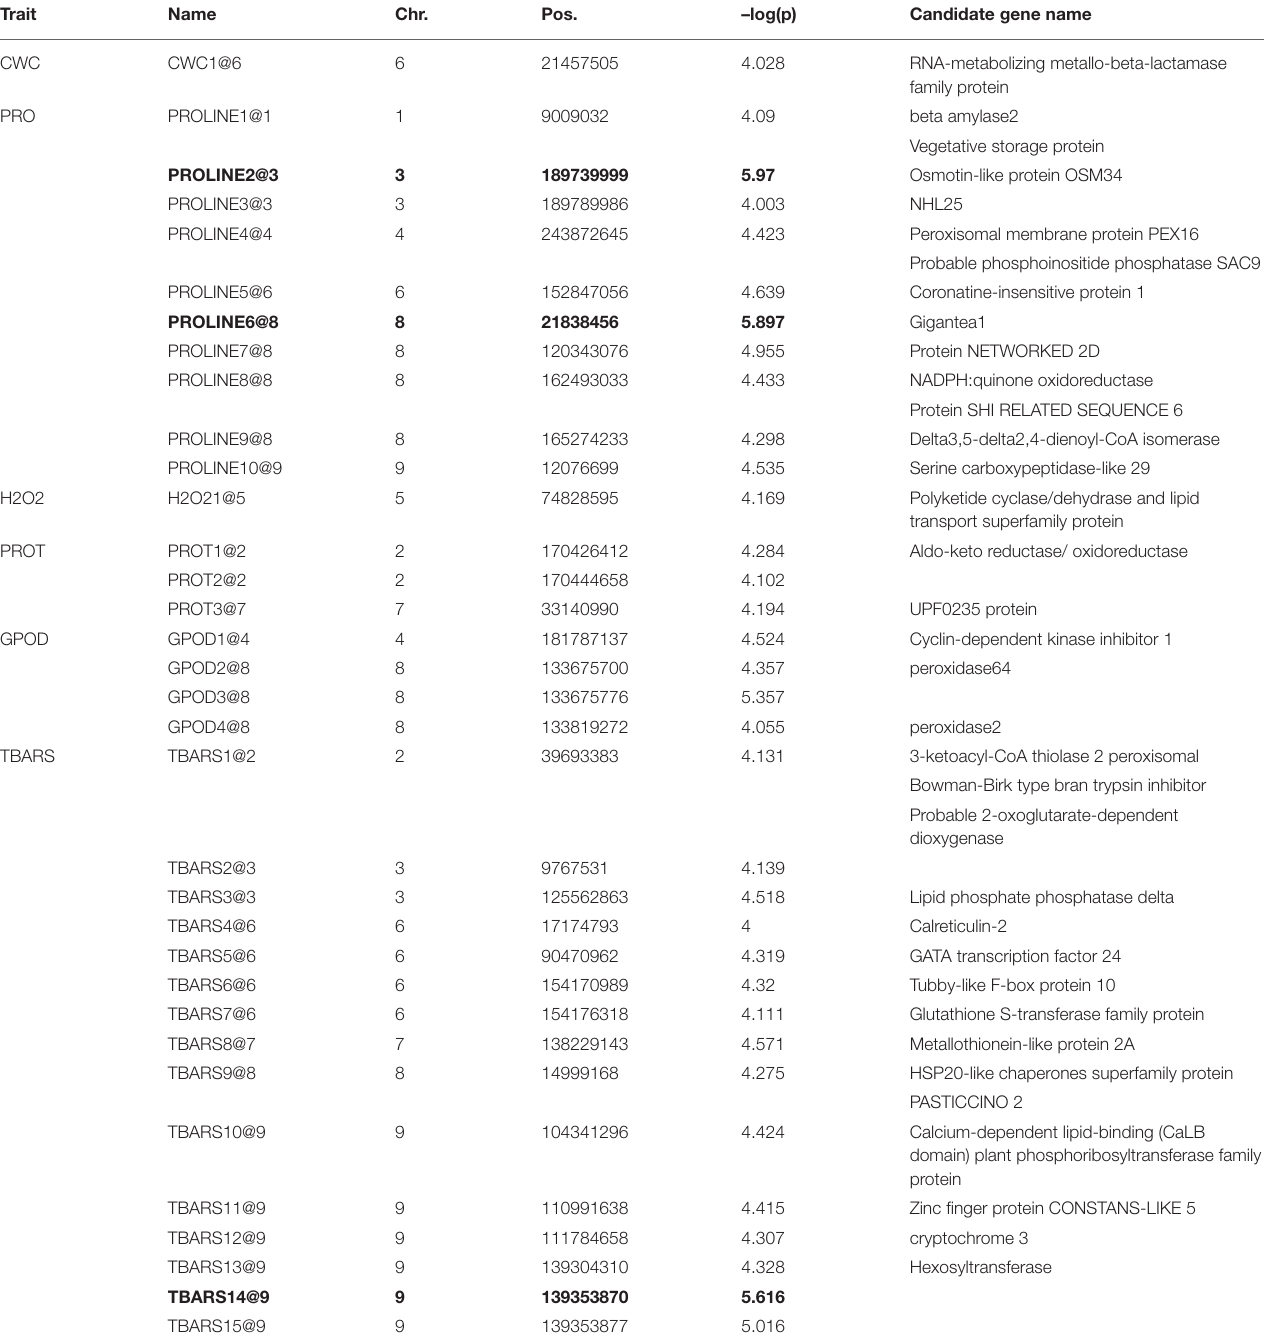
TABLE 3 | Summary of detected associations for Tr rel for GPOD (AU/g FW) PROT (mg/g FW), TBARS (ng/g FW), proline (nmol/mg FW), H 2 O 2 (nmol/g FW) and CWC (%) crossing the –log(p) significance threshold of 4.